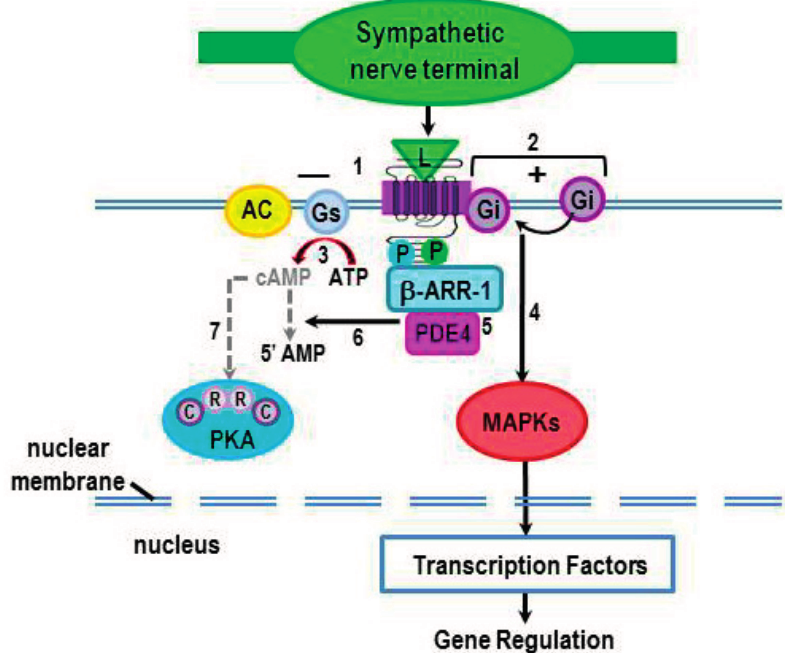
Figure 4. Phosphorylation of β 2 -ARs by PKA induces a conformational change that impairs Gs binding (#1), but enhances Gi binding (#2) to the receptor. This transient shift in receptor coupling prevents activation of AC and thus, inhibits signaling via cAMP